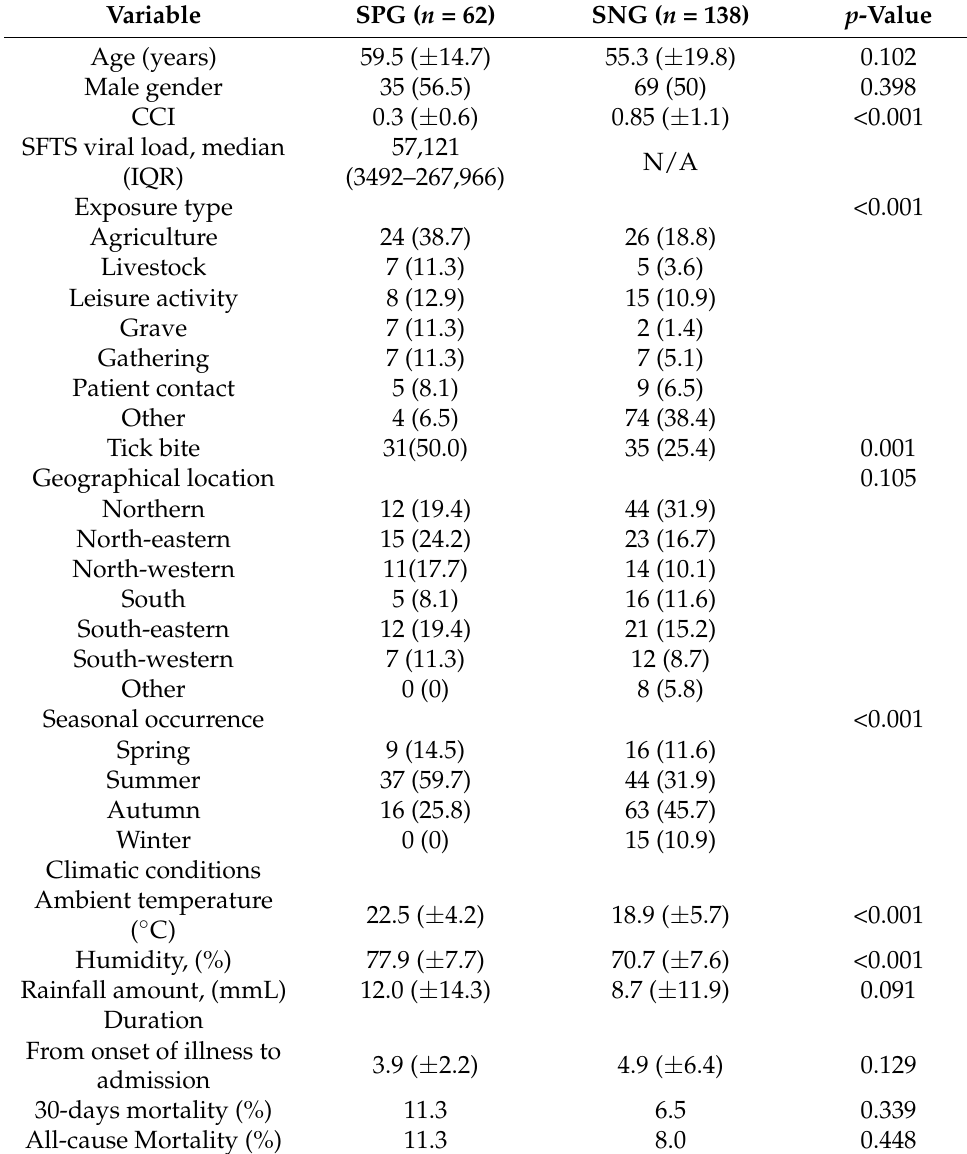
Table 1. Baseline demographic and clinical characteristics between patients with positive (SPG) and negative (SNG) severe fever with thrombocytopenia syndrome reverse transcription polymerase chain reaction